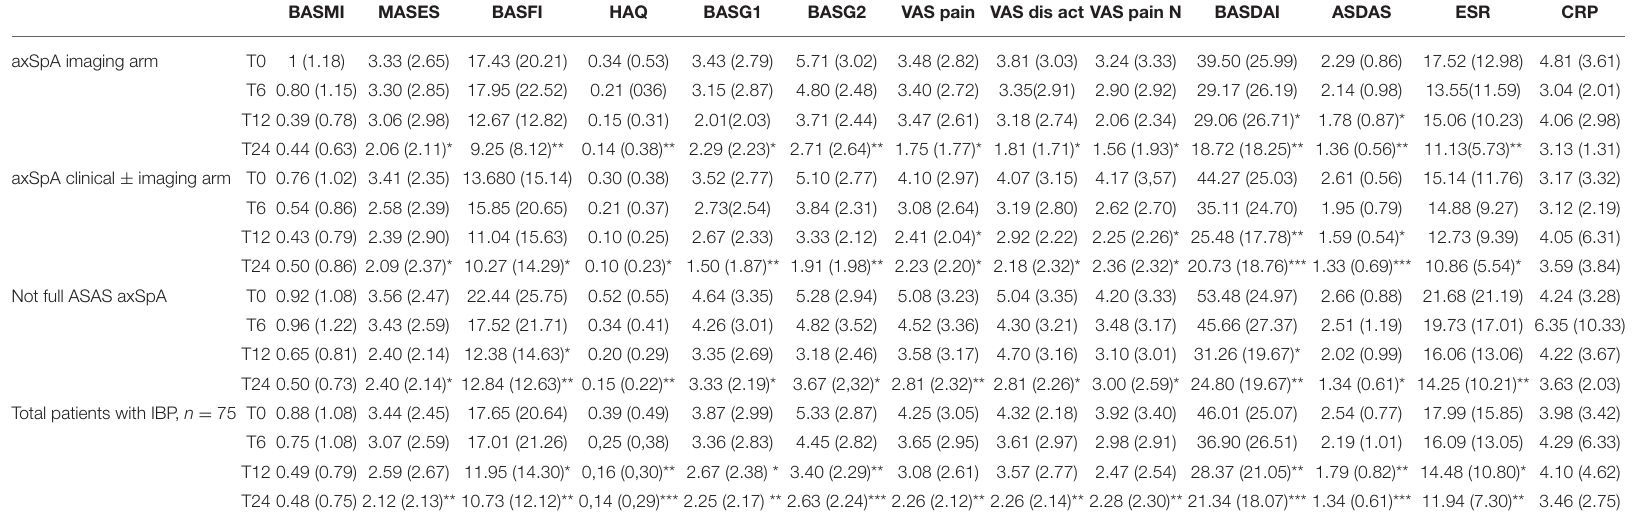
Data are expressed as mean ± SD. The test Kruskal Wallis repeated measures test and Dunn’s multiple comparison test were used. *** p < 0.0001 vs. T0, ** p < 0.001 vs. T0, * p < 0.01 vs. T0. BASMI,bathankylosingscoremetrologyindex;MASES,maastrichtankylosingspondilitiesenthesitisscore;BASFI,bathankylosingspondylitisfunctionalindex;HAQ,healthassessmentquestionnaire;BASG1,bathankylosingspondylitis patient global score 1; BASG2, bath ankylosing spondylitis patient global score 2; ESR, erytrocyte sedimentation rate; CRP, C-reactive protein; BASDAI, bath ankylosing spondylitis disease activity index; ASDAS, ankylosing spondylitis disease activity score; VAS pain, visual analog scale pain; VAS dis act, visual analog scale disease activity; VAS pain N, visual analog scale pain